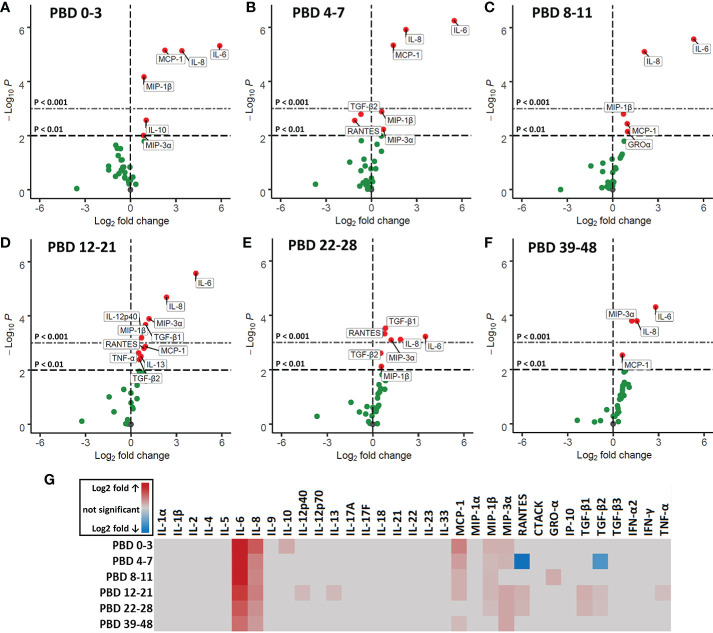
Volcano plots of 33 plasma immune factors after severe burn injury. Soluble mediators were analyzed in plasma of burn patients and healthy controls by Luminex immunoassay: MCP-1 (CCL2), MIP-1α (CCL3), MIP-1β (CCL4), MIP-3α (CCL20), GRO-α (CXCL1), IP-10 (CXCL10), IFN-α2, IFN-γ, TNF-α, TGF-β1, TGF-β2, TGF-β3, CTACK (CCL27), RANTES (CCL5), IL-1α, IL-1β, IL-2, IL-4, IL-5, IL-6, IL-8 (CXCL8), IL-9, IL-10, IL-12p40, IL-12p70, IL-13, IL-17A (CTLA-8), IL-17F, IL-18, IL-21, IL-22, IL-23, and IL-33 (NF-HEV). Differences between burn and healthy group were expressed as (Log2) fold change of healthy group (n = 13) on the x-axis and the (-Log10) p value on the y-axis of various time intervals after burn. (A) PBD 0 to 3 (n = 10 patients). (B) PBD 4 to 7 (n = 14 patients). (C) PBD 8 to 11 (n = 13 patients). (D) PBD 12 to 21 (n = 15 patients). (E) PBD 22-28 (n = 13 patients). (F) PBD 39 to 48 (n = 8 patients). Because of multiple testing, we considered a p value of < 0.01 to be significant. Black dashed line shows p = 0.01, gray dashed line shows p = 0.001, green dots indicate non-significant changes and red dots show significant changes. (G) Heatmap of significant (p < 0.01) fold changes compared to healthy controls (Log2 fold). Fold changes are shown in gray (not significant), red (increase) or blue (decrease).